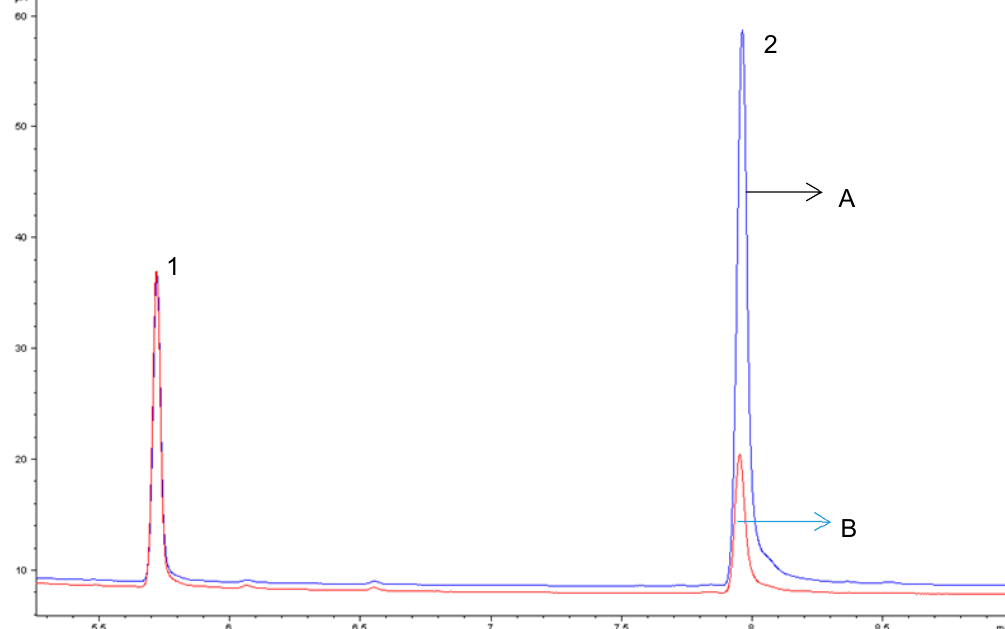
Figure 3. Gas chromatographic profiles of cholesterol in duck liver pâté from the control (A) and duck liver pâté treated with β -CD (B). Peak identification: 1 = cholestane, 2 = cholesterol.